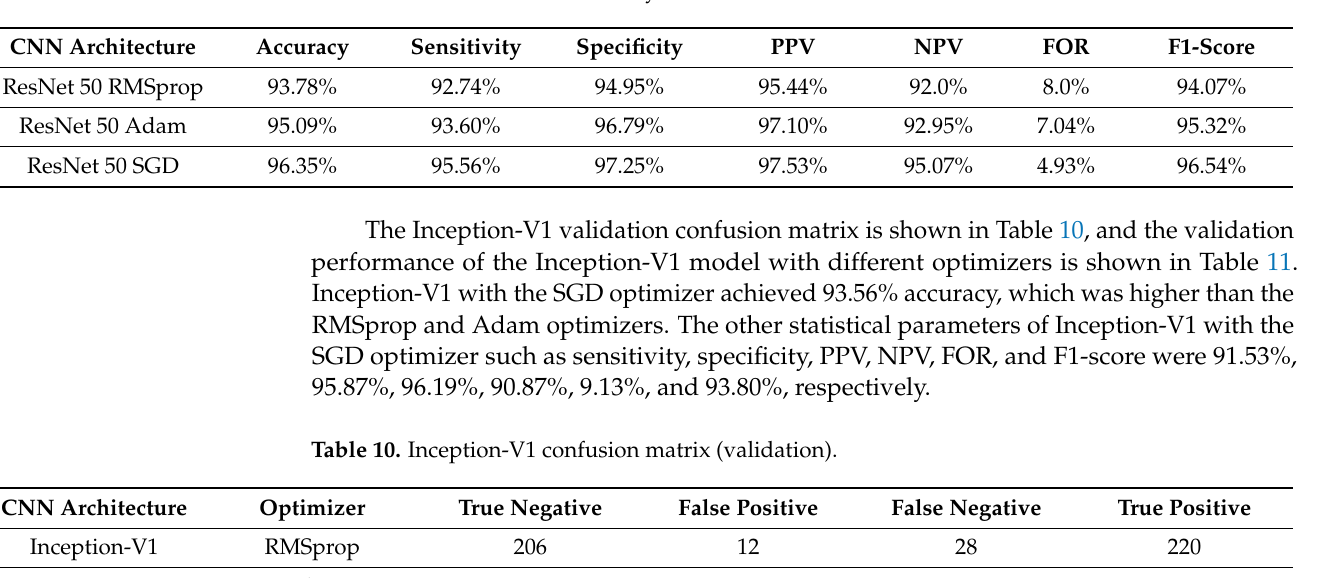
Table 9. Validation statistical analysis of the ResNet 50 model.